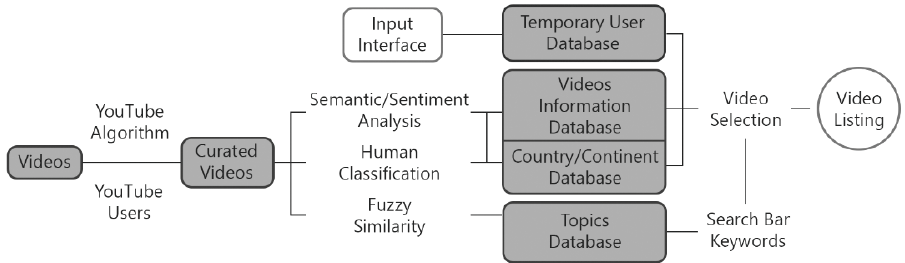
Fig. 1. Structure of the recommendation